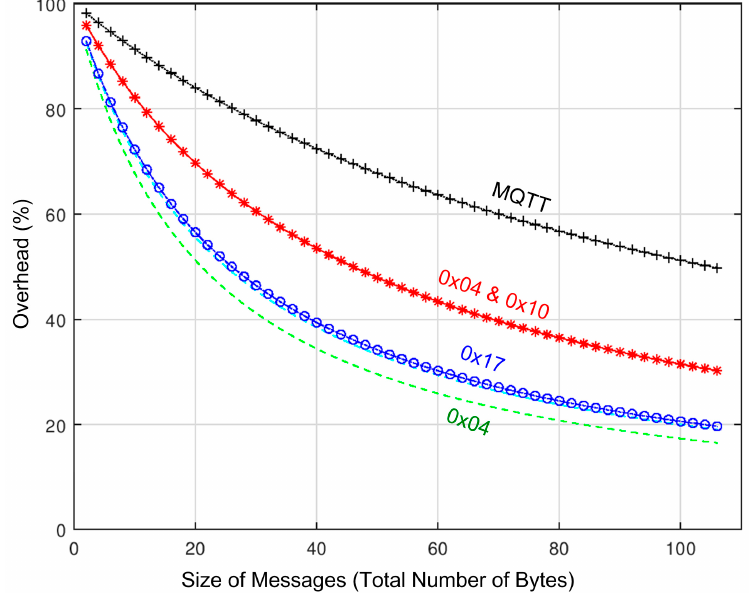
Figure 9. The overhead of an MQTT message compared to that of MODBUS.